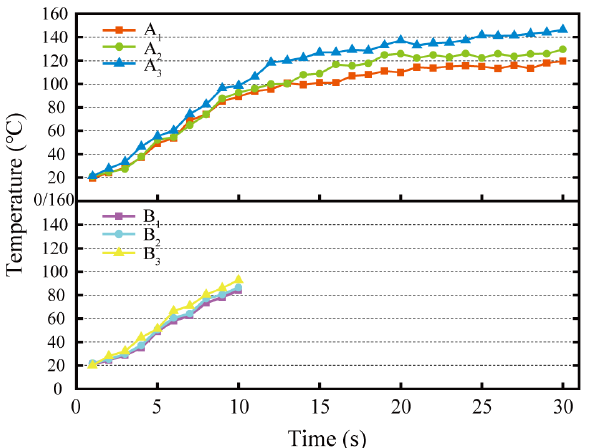
Figure 11. Grinding temperature of rail samples by grinding wheels under different grinding times.